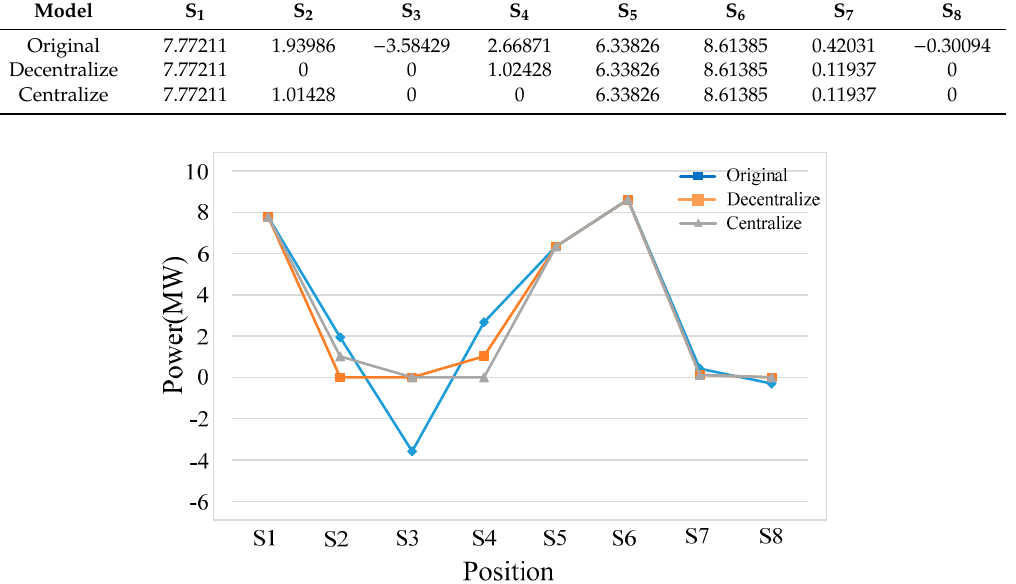
Figure 22. Results before and after control in case 1